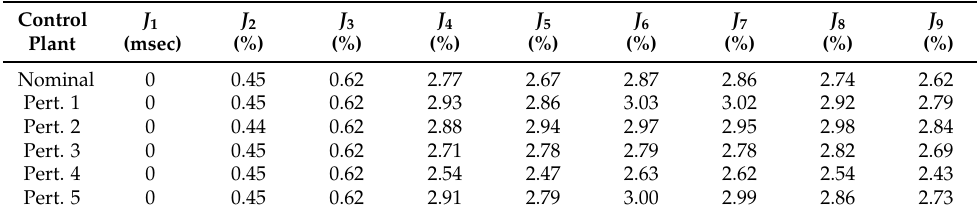
Table 7. Evaluation criteria (Damaged w/ d, El Centro earthquake, Case 1).